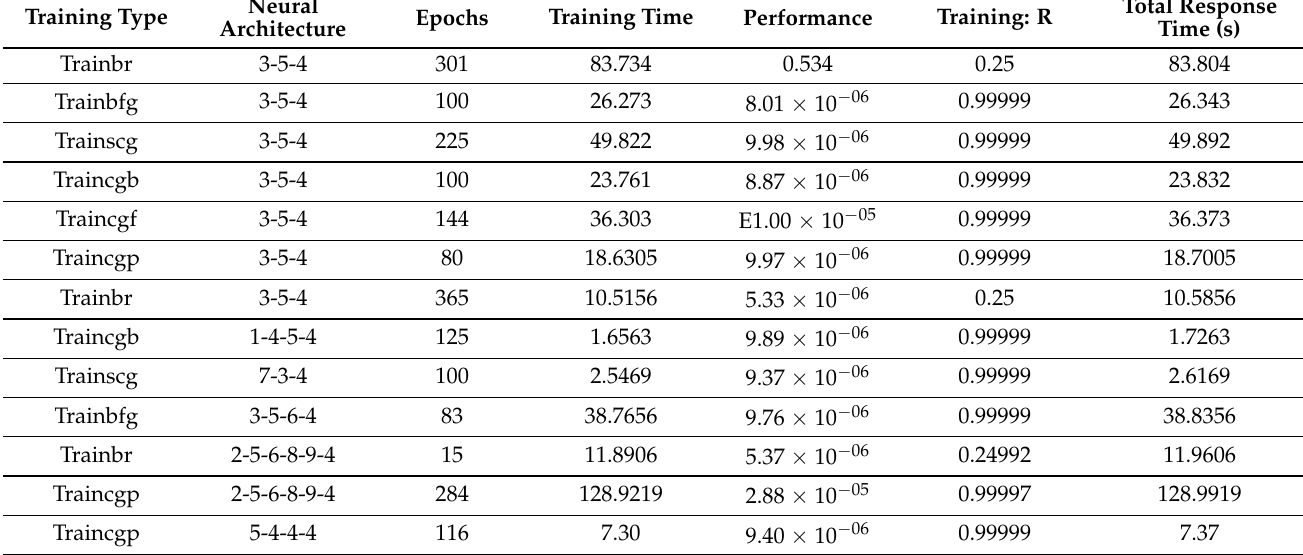
Table 2. Simulation of neural architectures for mobile robots.